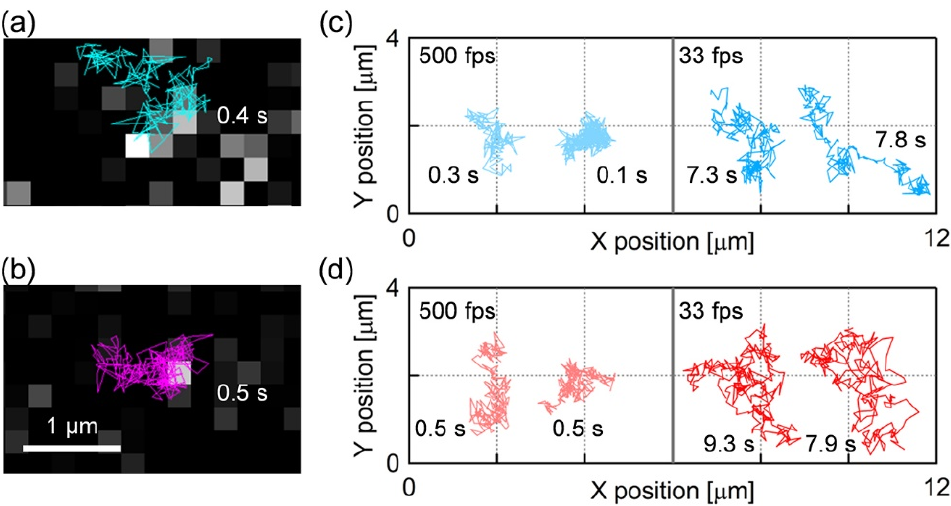
Figure 2. ( a , b ) Single molecule fluorescence images and diffusion trajectories of ( a ) BODIPY-HPC and ( b ) DiI-C18 in PI+PC-SLB obtained by SPT at the frame rate of 500 fps. ( c , d ) Single molecule trajectories of ( c ) BODIPY-HPC and ( d ) DiI-C18 in PI+PC-SLB. Left and right columns correspond to the trajectories obtained at 500 fps and 33 fps, respectively. The length (measurement time) of each trajectory is appended.